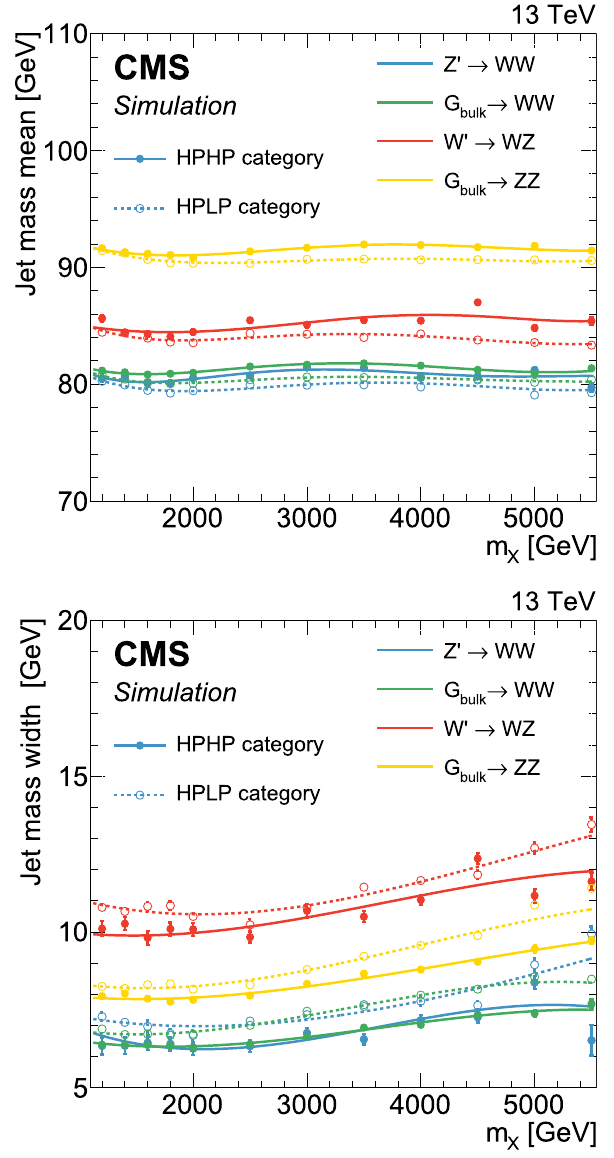
Fig. 8 The mass scale (upper) and resolution (lower) of the jet as a function of m X , obtained from the mean and width of the dCB function used to fit the jet mass spectrum. The HPHP (solid lines) and HPLP (dotted lines) categories are shown for different signal models. The distributions are only shown for one of the two jets in the event, since the distributions for the second jet are essentially the